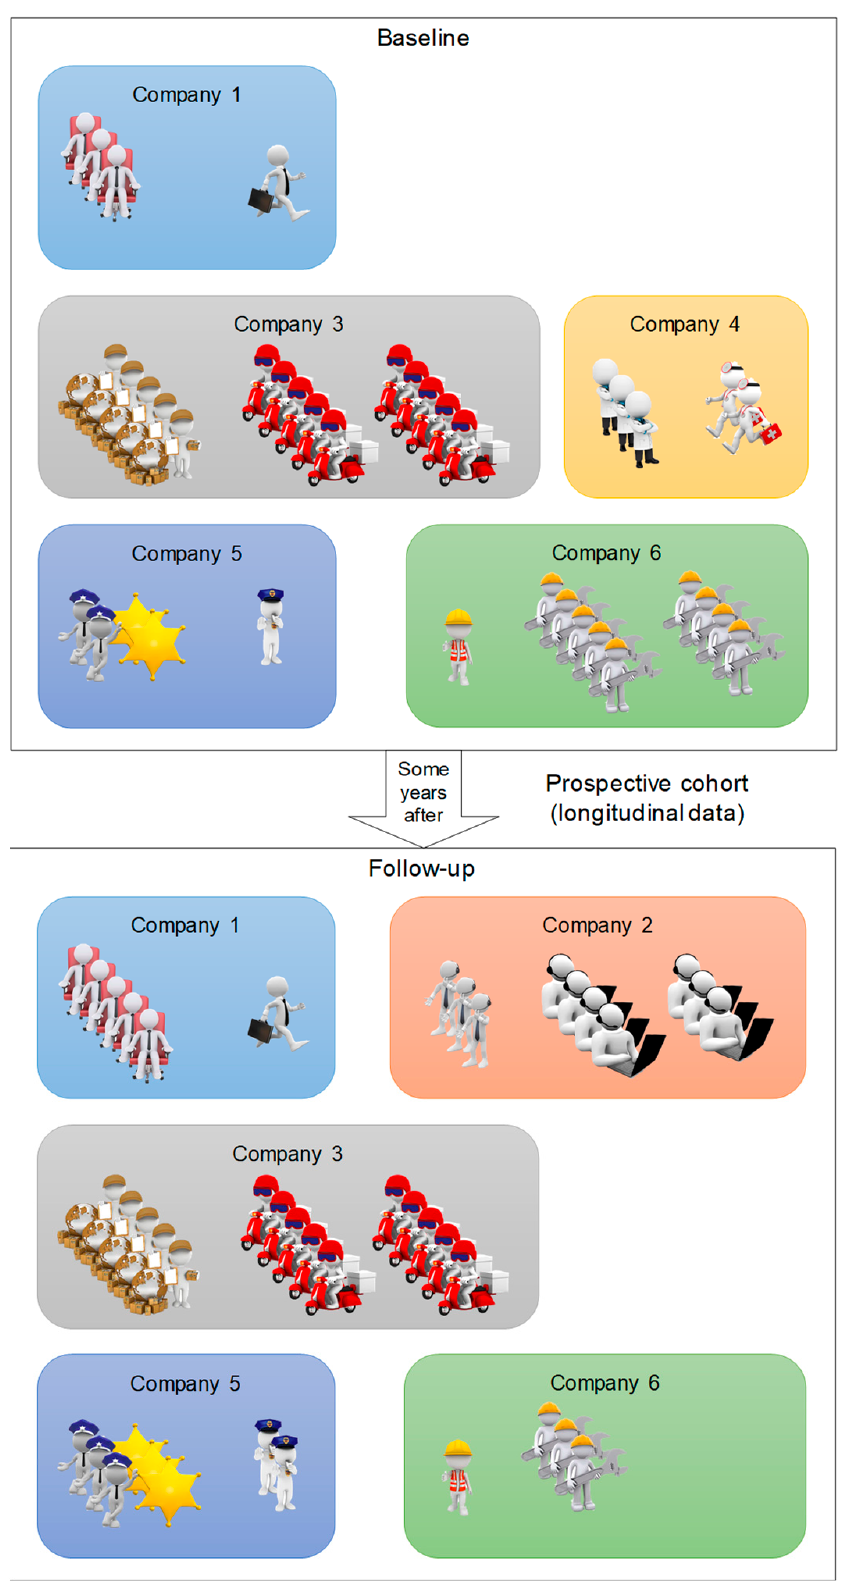
Figure 2. Example of cluster-correlated data: here, a prospective cohort of workers from multiple companies is followed over time.